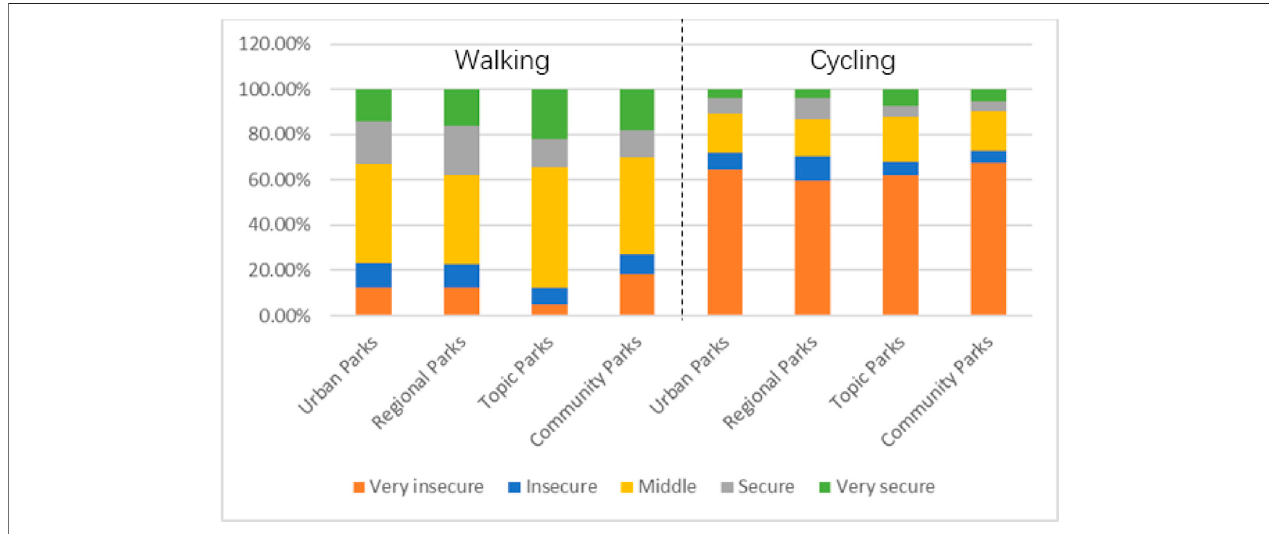
FIGURE 9 | Stacked diagram of ATTS situation proportion near different